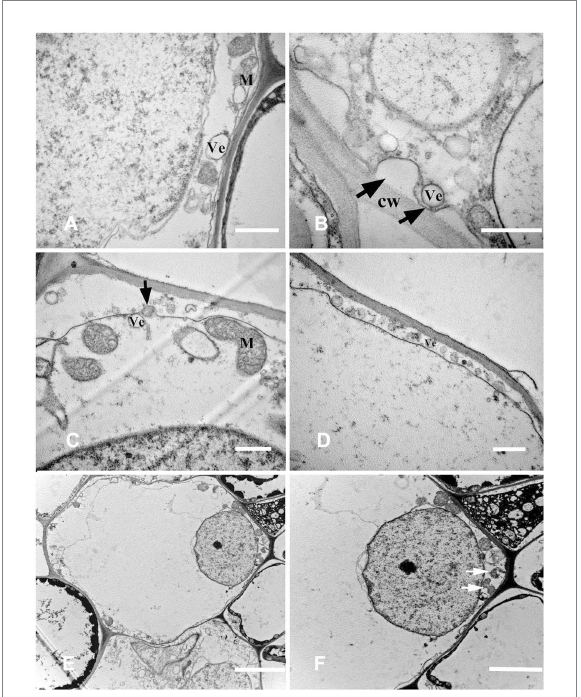
FIGURE 5 Cell ultrastructure of aerenchyma formation in Nelumbo nucifera roots (II). (A–C) The cells in the aerenchyma formation stage. (A) Membranous structures increased; (B) A small amount of granular material in the membrane structure; (C) Nuclear membrane invagination. (D–H) The cells in the aerenchyma expansion stage. (D) Highly vacuolar cortical parenchyma cells; (E) Distribution of organelles; (F) Endoplasmic reticulum secreted vesicle; (G) Plasma membrane distorted and overlapped; (H) Cytoplasmic degradation and vesicles appeared. M, mitochondria; N, nucleus; V, vacuole; Ve, vesicle; CW, cell wall; and PLA, plasma membrane. Bars: A,B = 0.5 μ m, C,E,F = 1 μ m, D,G,H = 2 μ m.